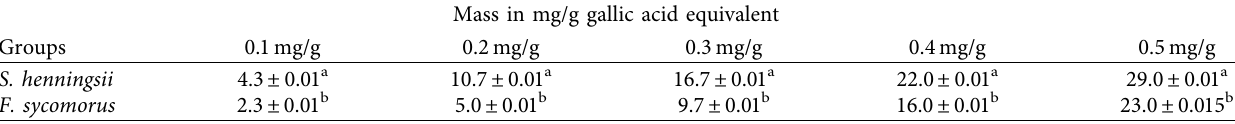
Table 2: Total phenolic contents of DCM extracts of S. henningsii and F. sycomorus .